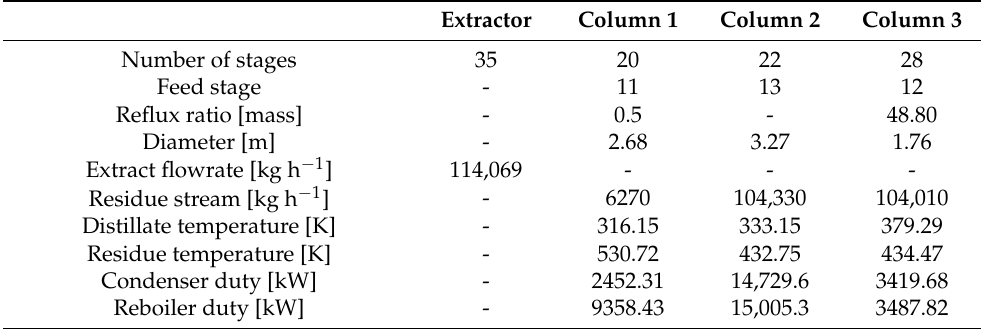
Table 4. Design parameters and operative variables for the configuration